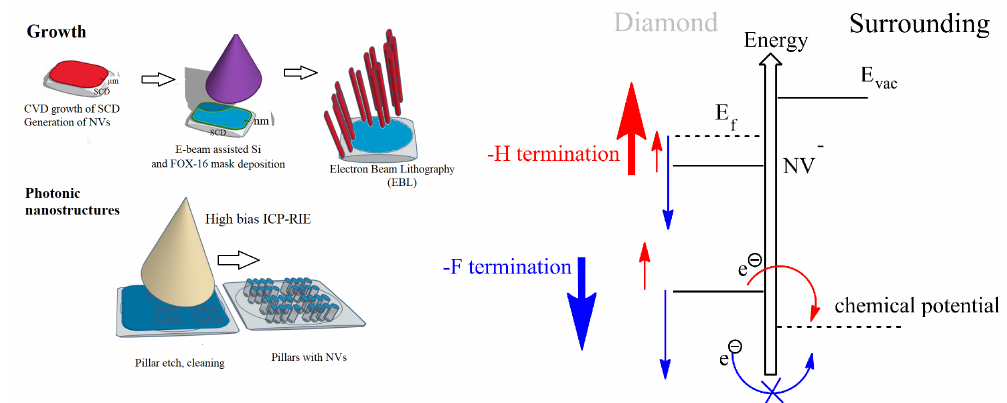
Figure 1. Left : generation of photonic nanostructures in chemical vapor deposition (CVD)-grown single crystal diamond containing naturally grown-in, negatively charged nitrogen vacancies. Right : Effects of surface termination on the electron loss from a negatively charged nitrogen vacancy on example hydrogen and fluorine termination. In this study plasma fluorination with heavy SF 6 ions was